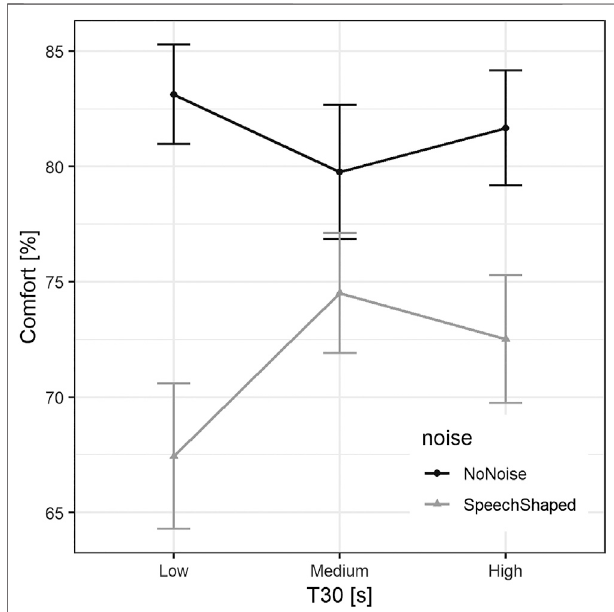
FIGURE 6 | Mean self-reported vocal comfort in % (0 (cid:2) ‘ not at all comfortable ’ ,100 (cid:2) ‘ extremelycomfortable ’ )acrossparticipants per T30.The error bars indicate ± standard error.